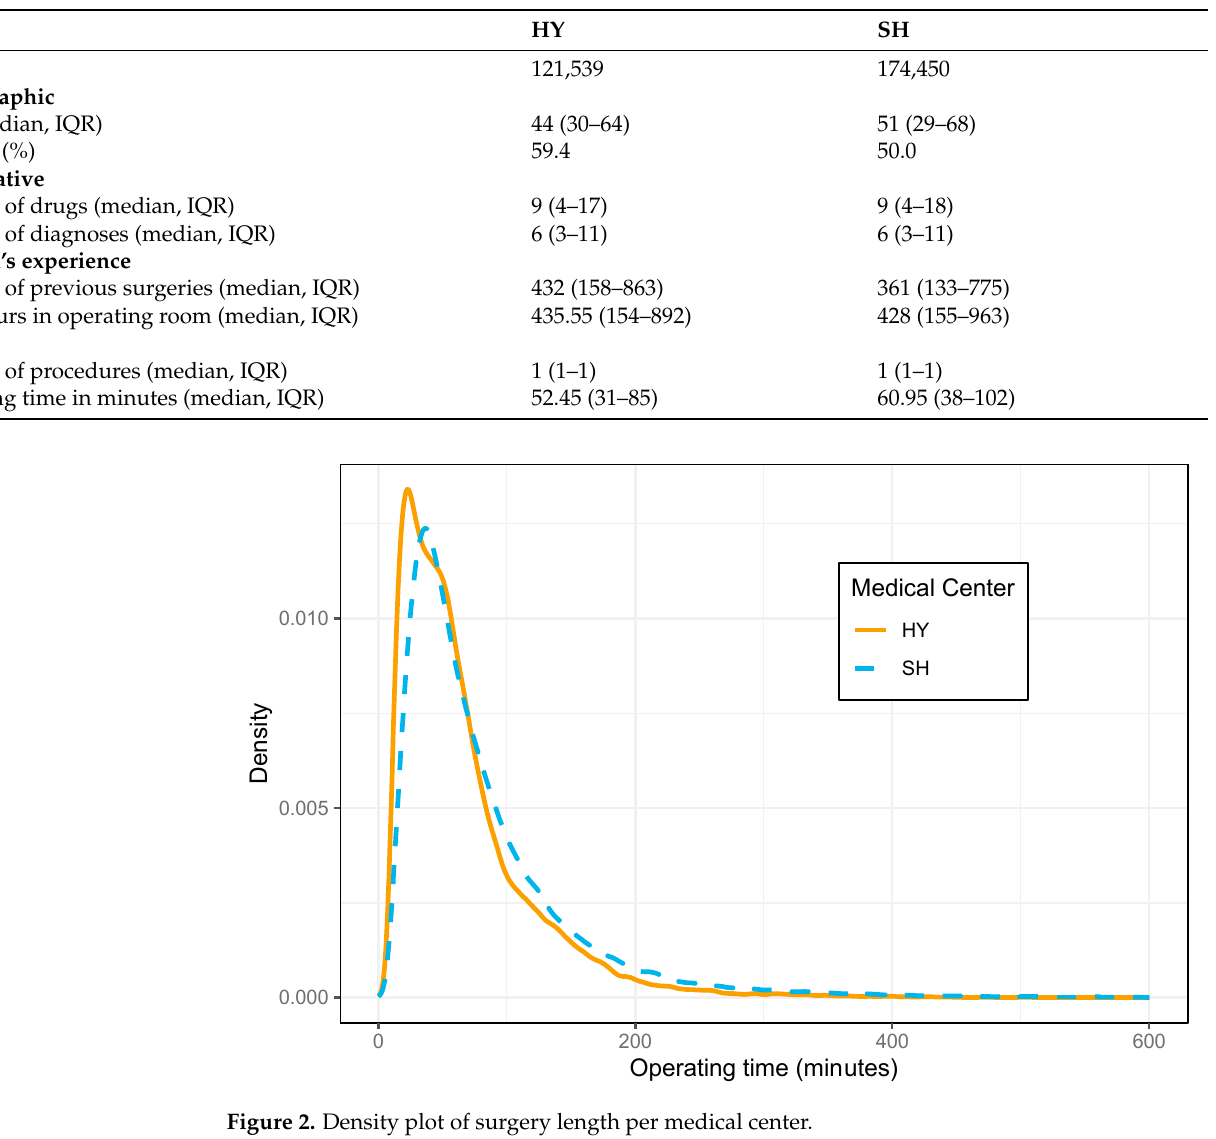
Figure 2. Density plot of surgery length per medical center.